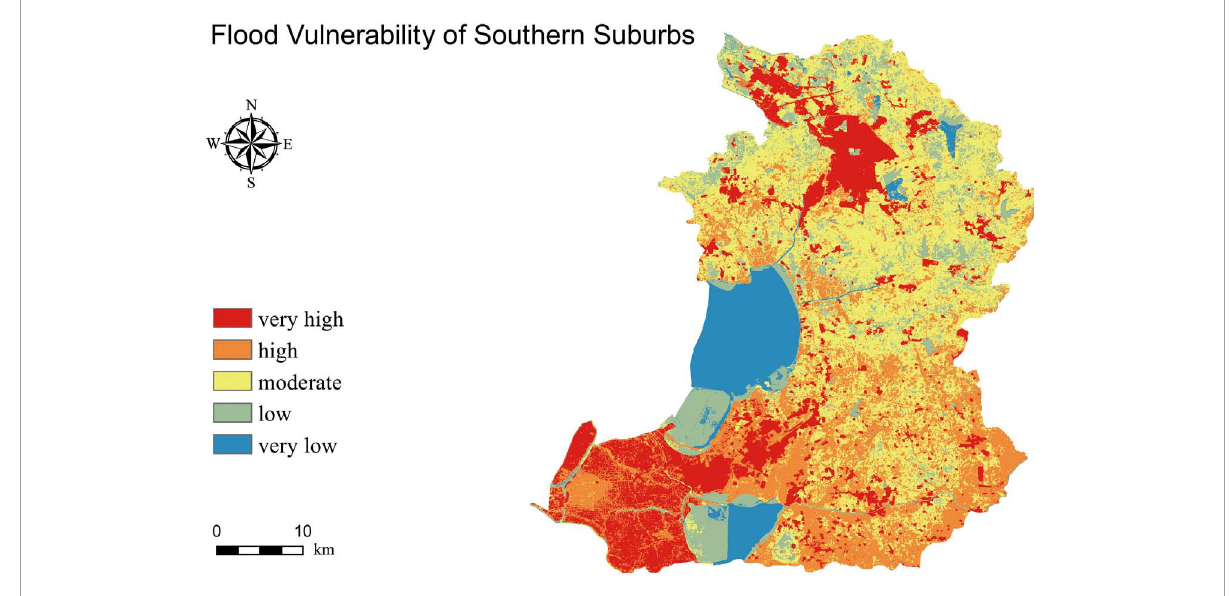
FIGURE8 The flood vulnerability levels of southern